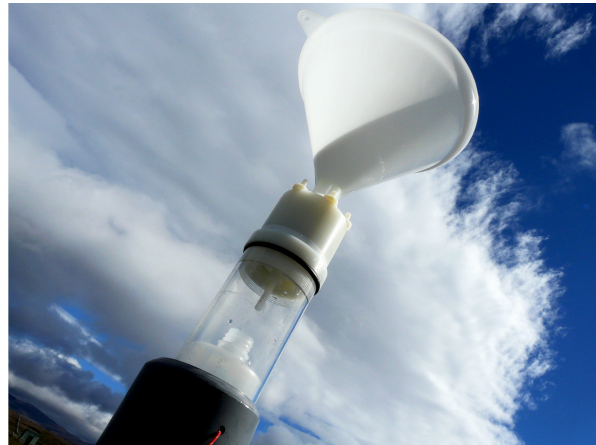
Fig. 2a. Rainwater sampling device on the top of its PVC tube.